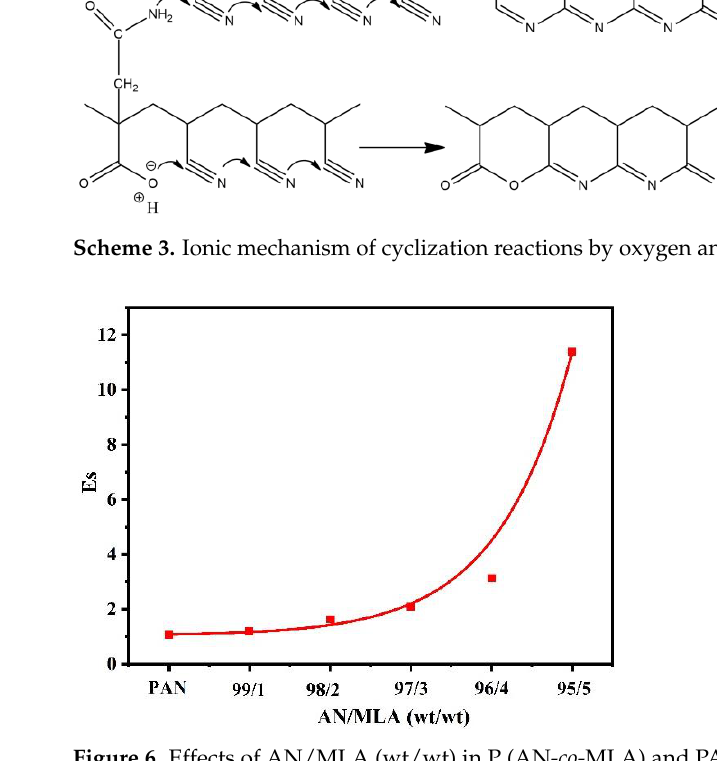
Figure 6. Effects of AN/MLA (wt/wt) in P (AN -co- MLA) and PAN homopolymer on the extent of stabilization ( Es ).